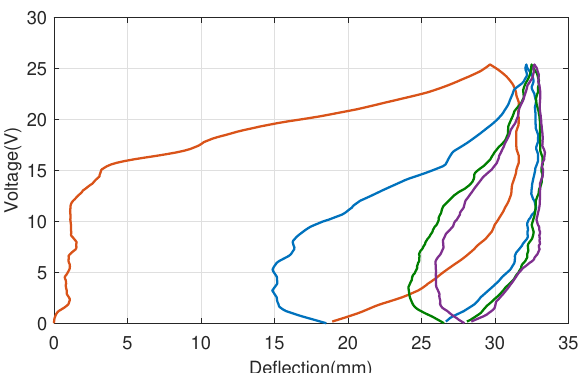
Figure 3. Four consecutive heating up and cooling down cycles of shape memory alloy with